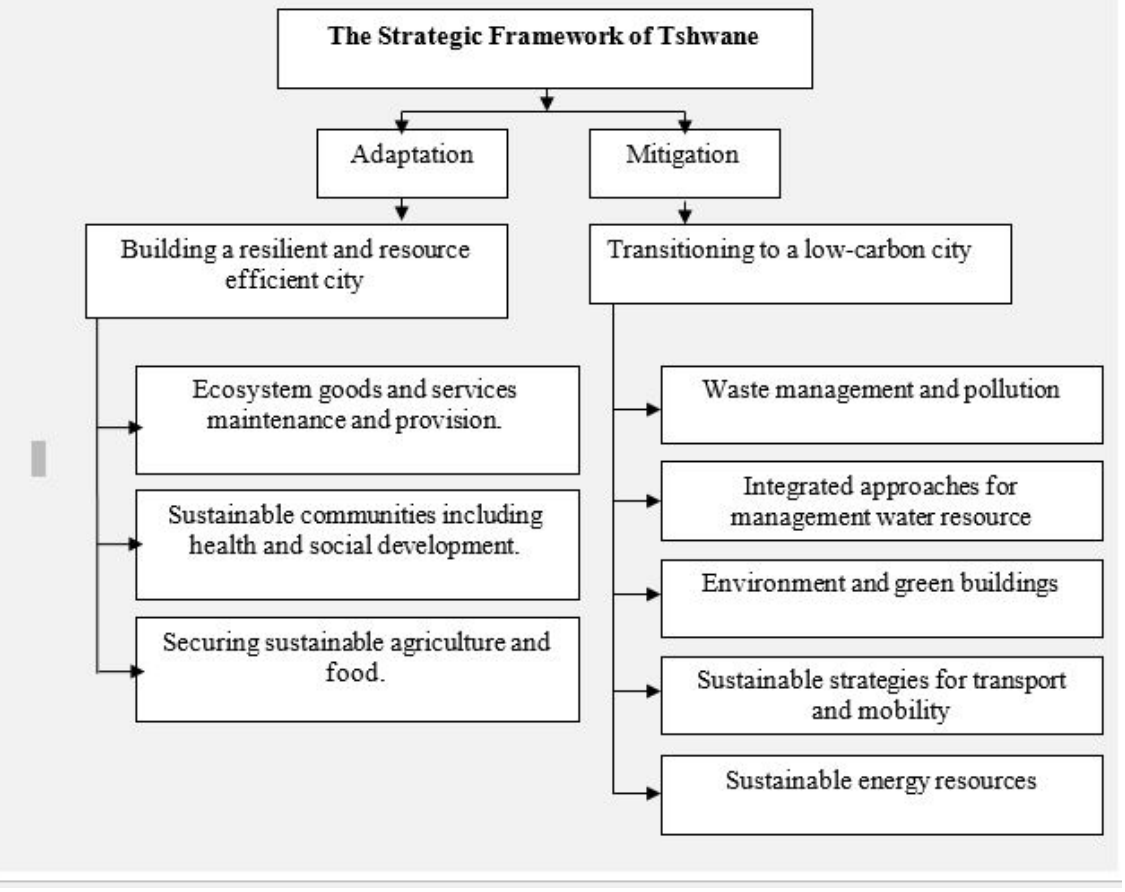
Figure 2. The strategic framework of Tshwane Reference: Framework fora Green Economy Transition, City of Tashwane, http ://carbonn.org/uploads/tx